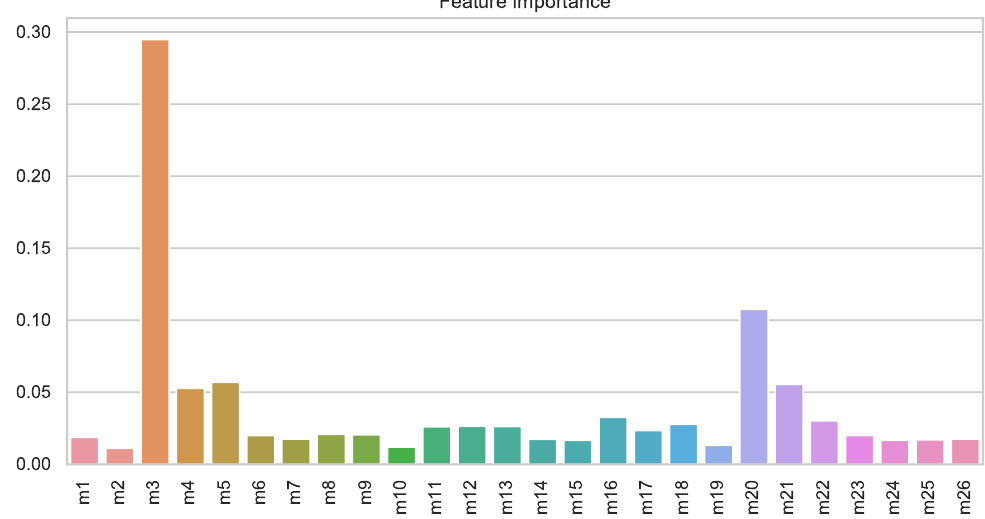
Figure 12. Relative feature importance of the 26 first principal components in the XGBoost